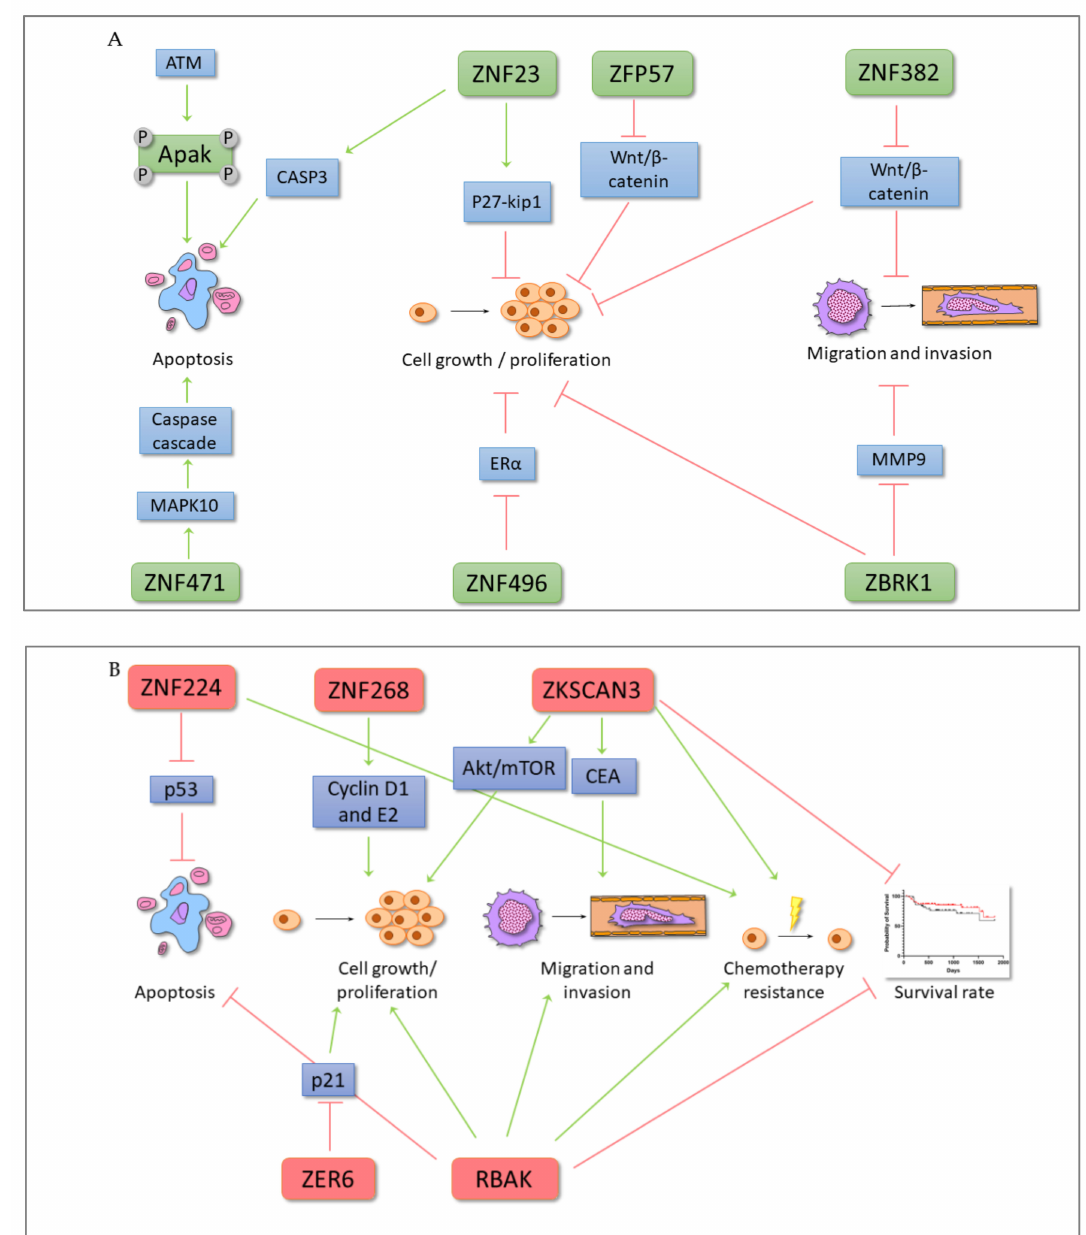
Figure 6. An influence of selected KRAB-ZFP TSGs ( A ) and oncogenes ( B ) on various cancer-related signaling pathways and phenotypic features in neoplastic cells. The schematic representation demonstrates selected KRAB-ZFPs with oncogenic and TSG properties and their impact on the cellular signaling, apoptosis, response to treatment, proliferation, migration, and invasion of cancer cells, as well as patient survival. Some signaling pathways are yet to be understood. Green arrow—induction, red—inhibition,